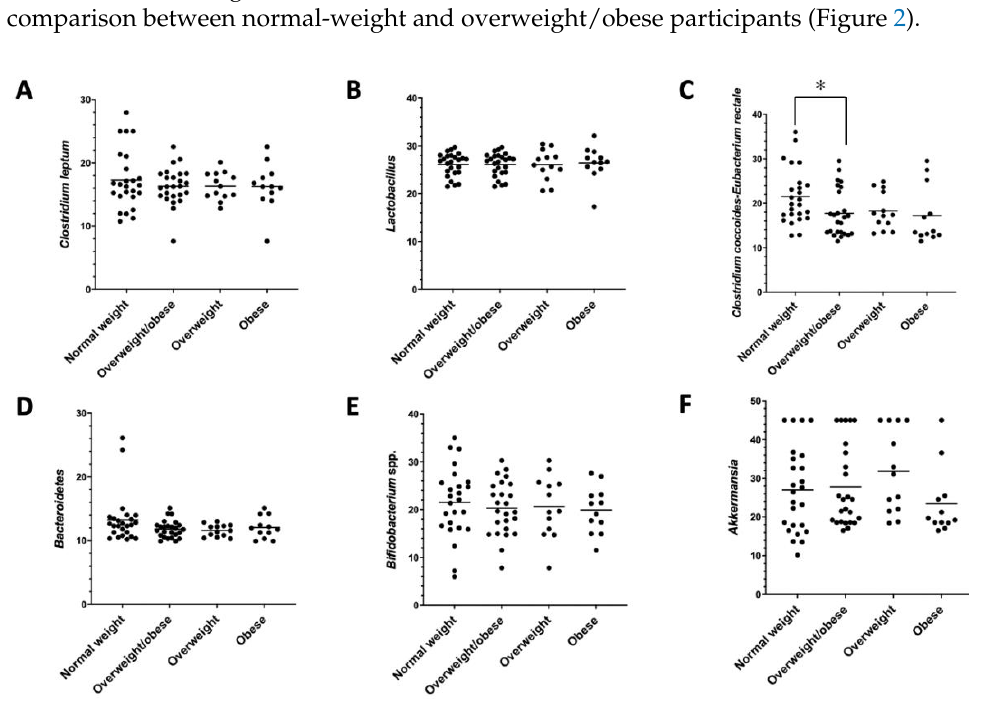
Figure 2. Microbial differences by qPCR. ( A ) Clostridium leptum , ( B ) Lactobacillus spp., ( C ) Clostridium coccoides-Eubacterium rectale , ( D ) Bacteroidetes , ( E ) Bifidobacterium spp., and ( F ) Akkermansia muciniphila . * p < 0.05, normal-weight vs. overweight/obese subjects.